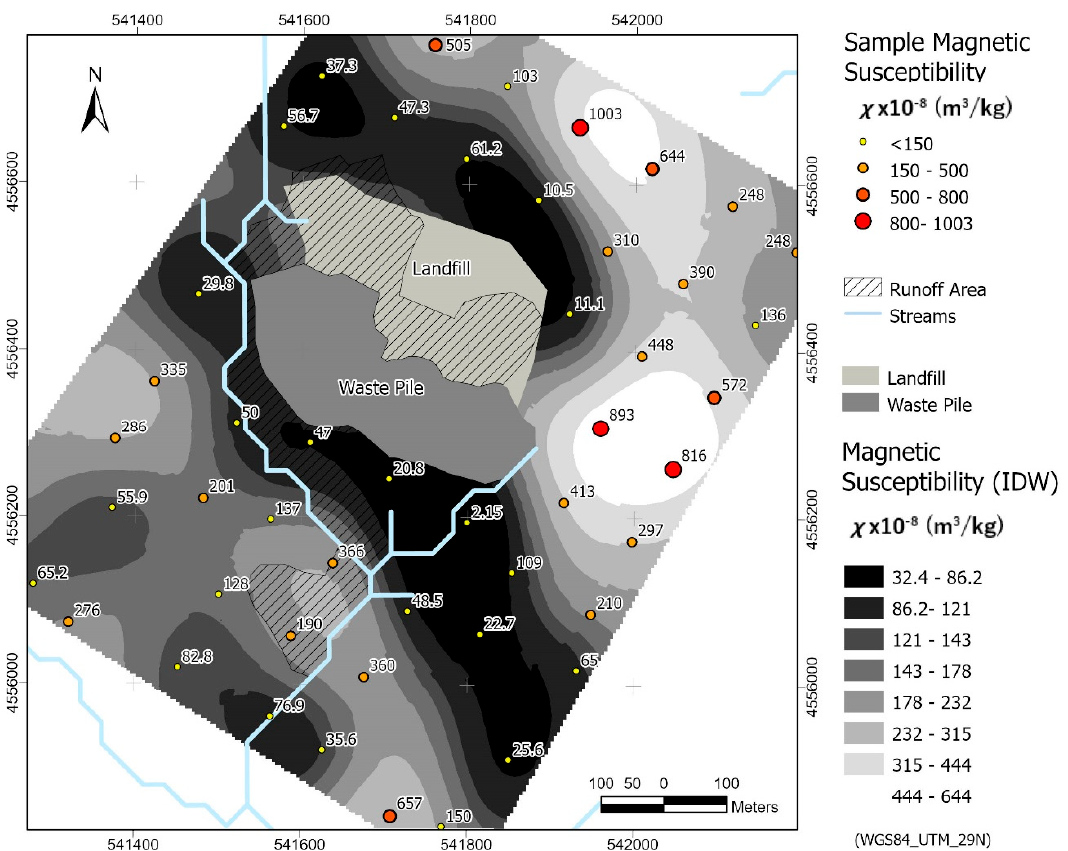
Figure 4. Soil magnetic susceptibility in the soils from the surrounding area of São Pedro da Cova waste pile.